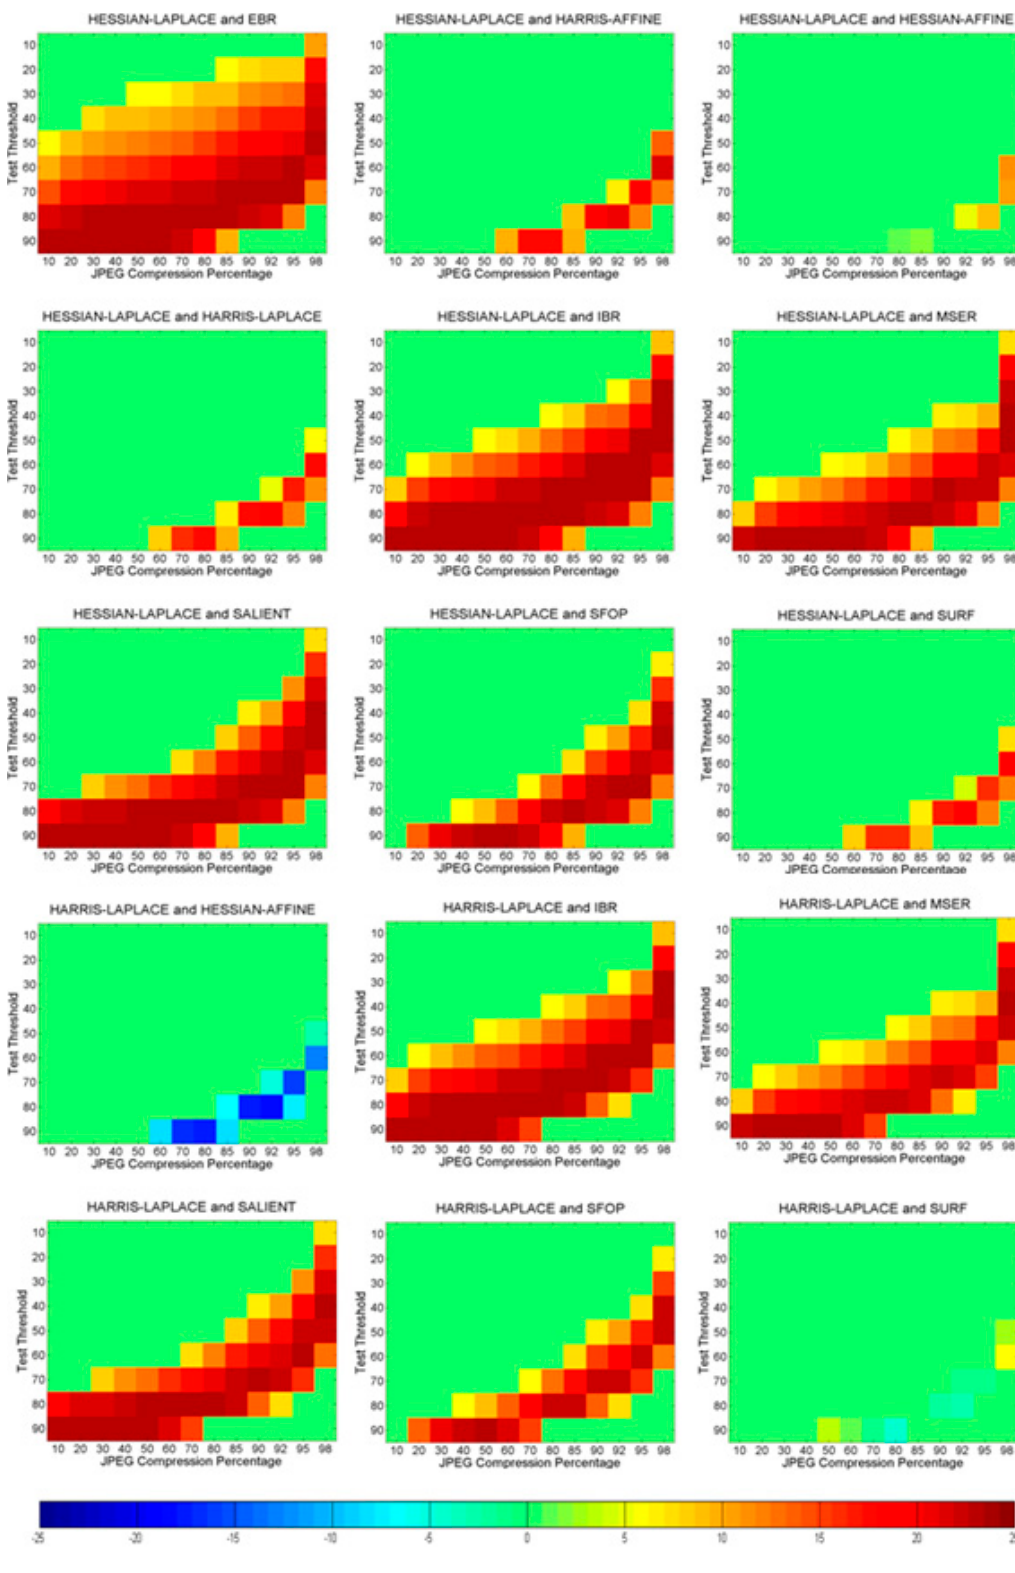
Figure 9. JPEG compression results for Harris-Laplace and Hessian-Laplace with other detectors showing Z -scores obtained; positive Z -scores indicate that the first detector is better than the second whereas negative values show the converse.